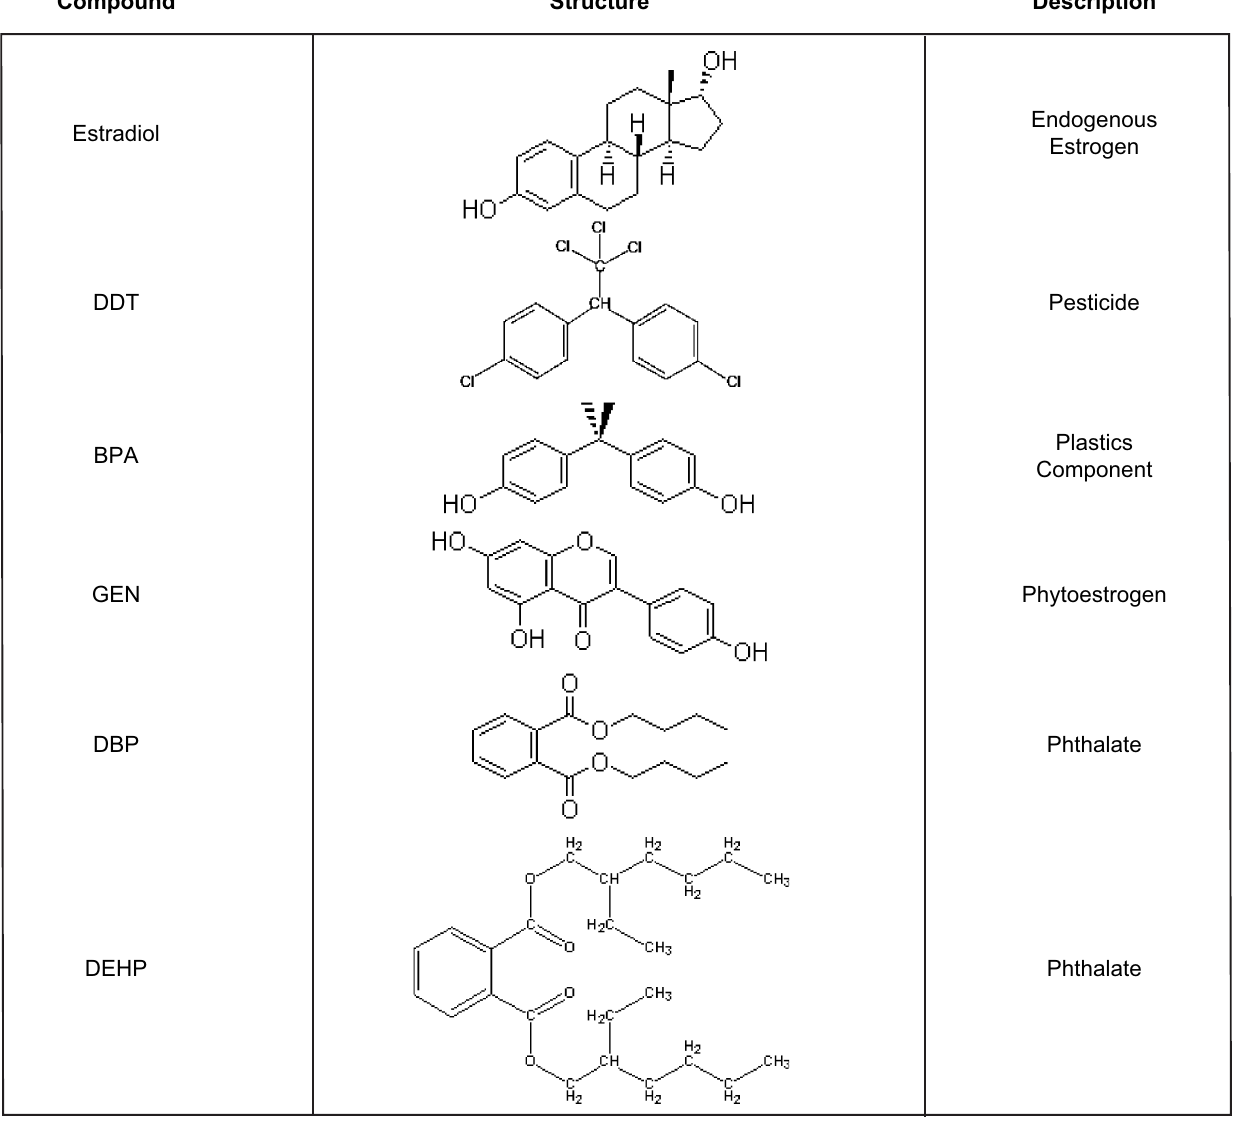
FIGURE 1 | Chemical structures and uses of common endocrine disruptors. DES, bisphenol-a and genistein are classifi ed as estrogen agonists while both of the phthalates are androgen antagonists. DDT is classifi ed as both an estrogen agonist and an androgen